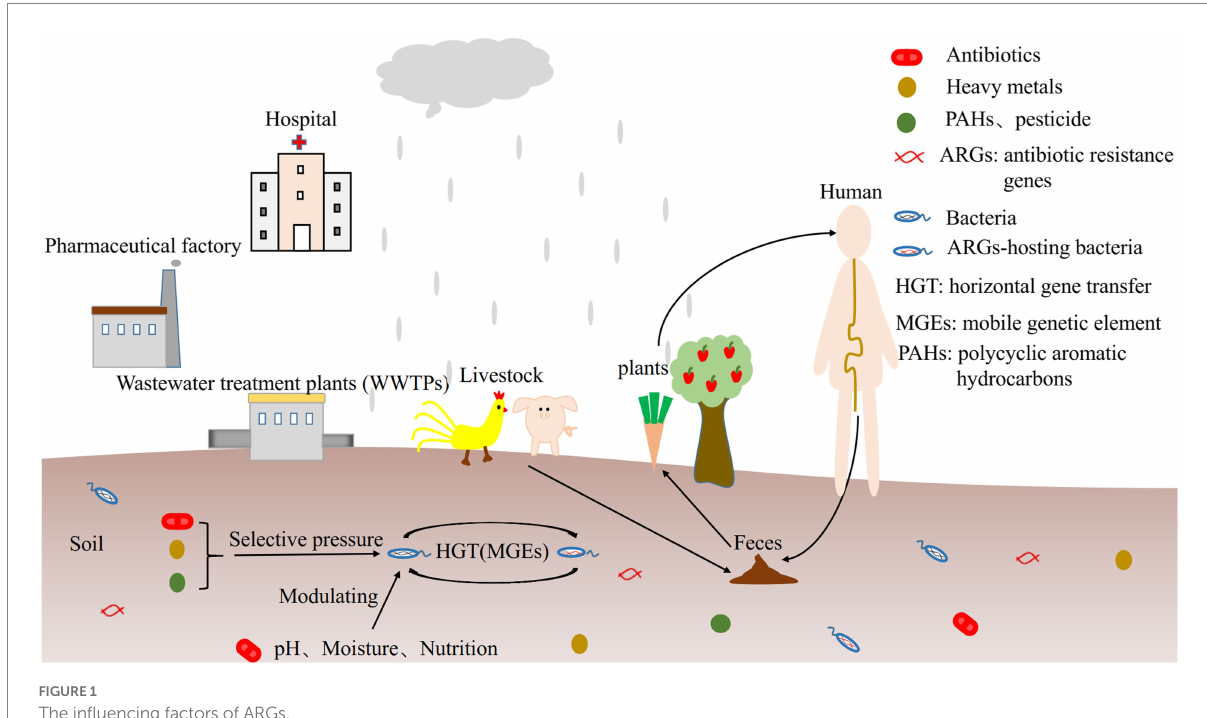
FIGURE 1 The influencing factors of